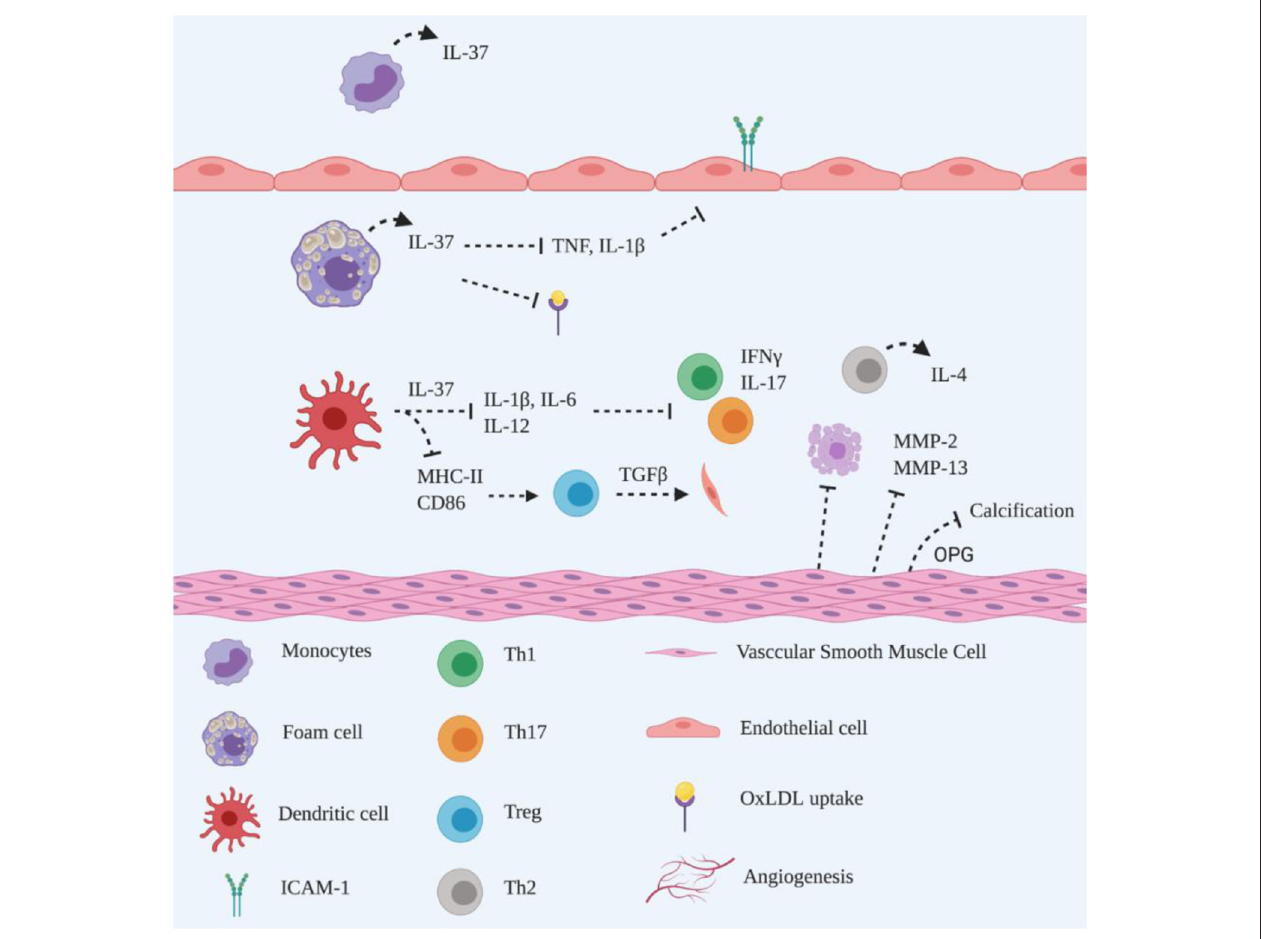
FIGURE 3 | Schematic representation of the roles of IL-37 in atherogenesis. IL-37 is constitutively expressed by monocytes in the unstimulated state. In pathological conditions, IL-37 is upregulated by foam cells to suppress pro-inflammatory cytokines secretion and reduce OxLDL uptake and adhesion molecules expression on endothelial cells. IL-37 downregulates MHC-II and CD86 on dendritic cells to induce Treg activation, promoting collagen deposition via TGF β production. Additionally, IL-37 reduces IL-1 β , IL-6 and IL-12 production, to suppress Th1 and Th17 polarisation accompanied by reduced IFN γ and IL-17 secretion. It remains unclear whether the Th2 population is induced by dendritic cells or IL-37 producing T lymphocytes. IL-37 triggers VSMC to reduce MMP-2 and − 13 production, attenuating collagen degradation and inhibiting apoptosis. IL-37 functions closely with VSMC-derived OPG, inhibiting vascular calcification. Created with